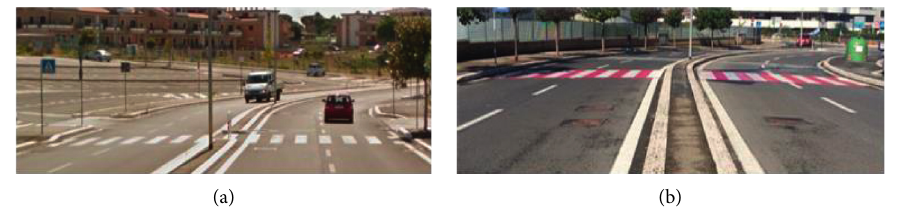
Figure 1: White zebra crossing (a) and red and white zebra crossing (b).